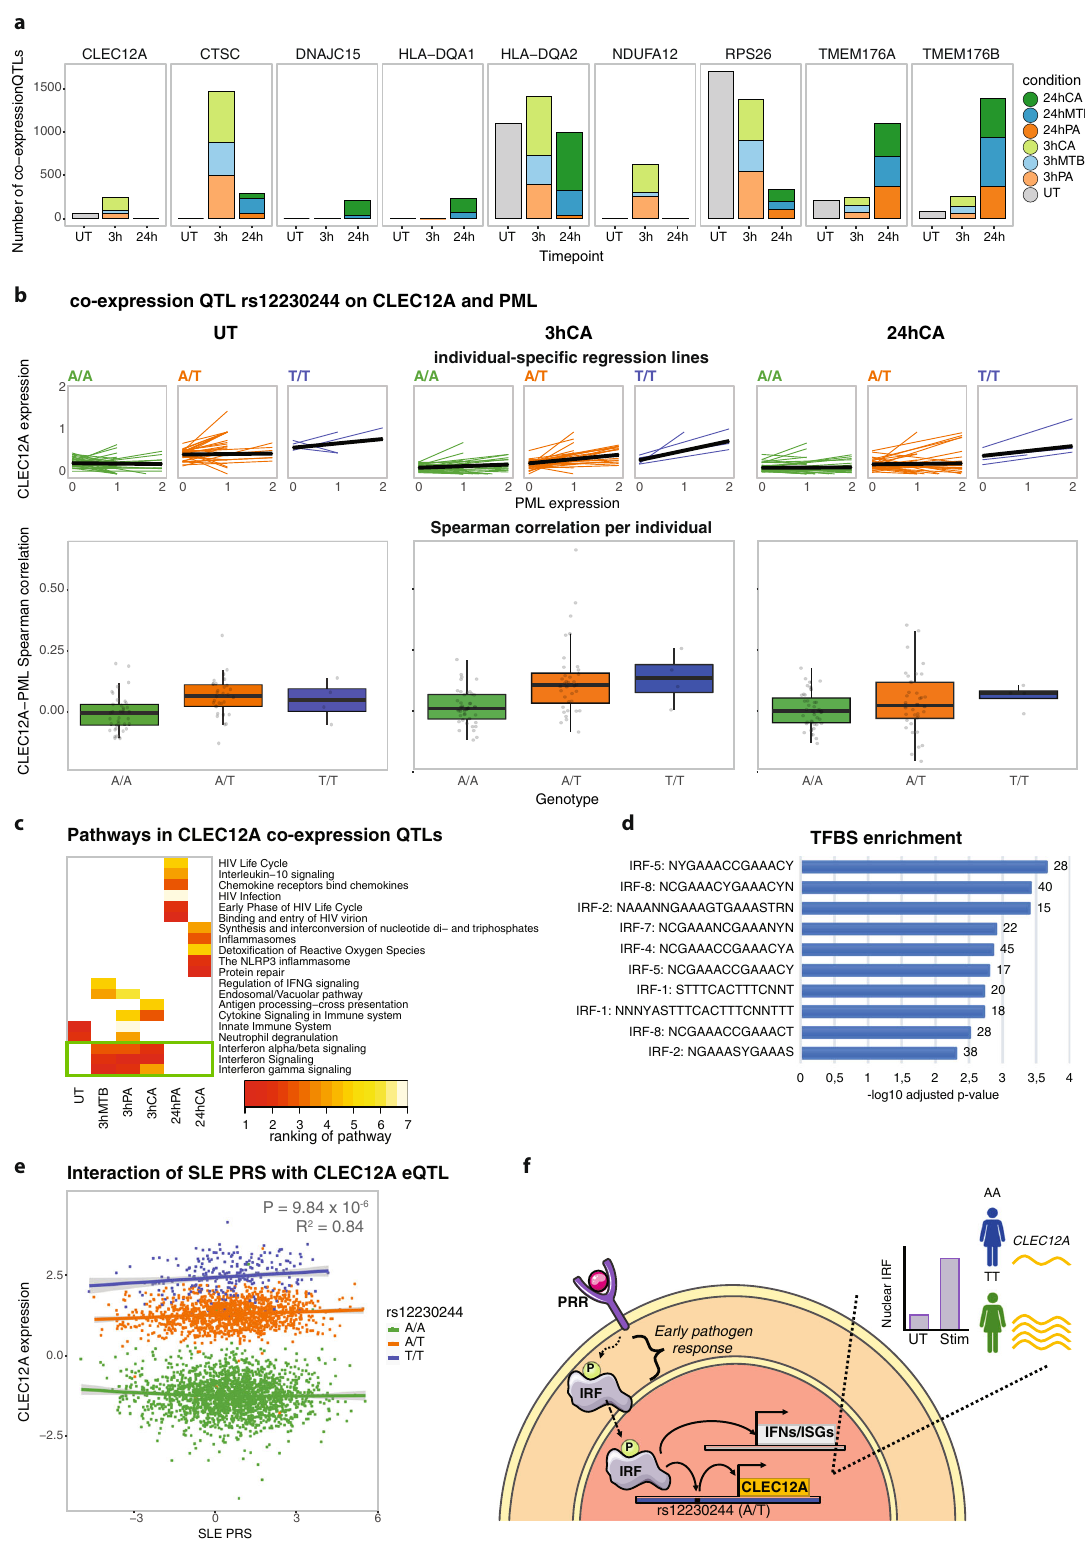
stimulation and 112 after 24 h stimulation (Fig. 4a, Supple- mentary Fig. 5b).